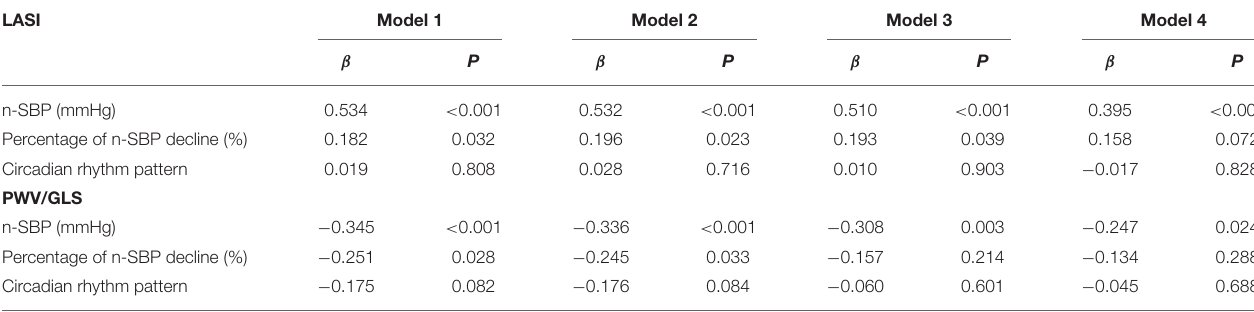
TABLE 6 | Multivariate linear regression